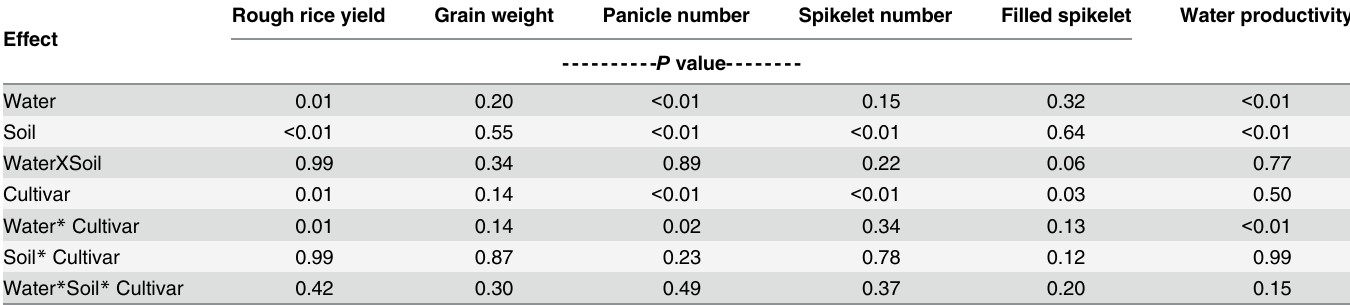
Table 2. Significance of the main effects [water regime (W), cultivar (CV), and soil texture (S)] and interactions among the main effects for rice grain yield and yield components across environments for clay and silt loam soil.